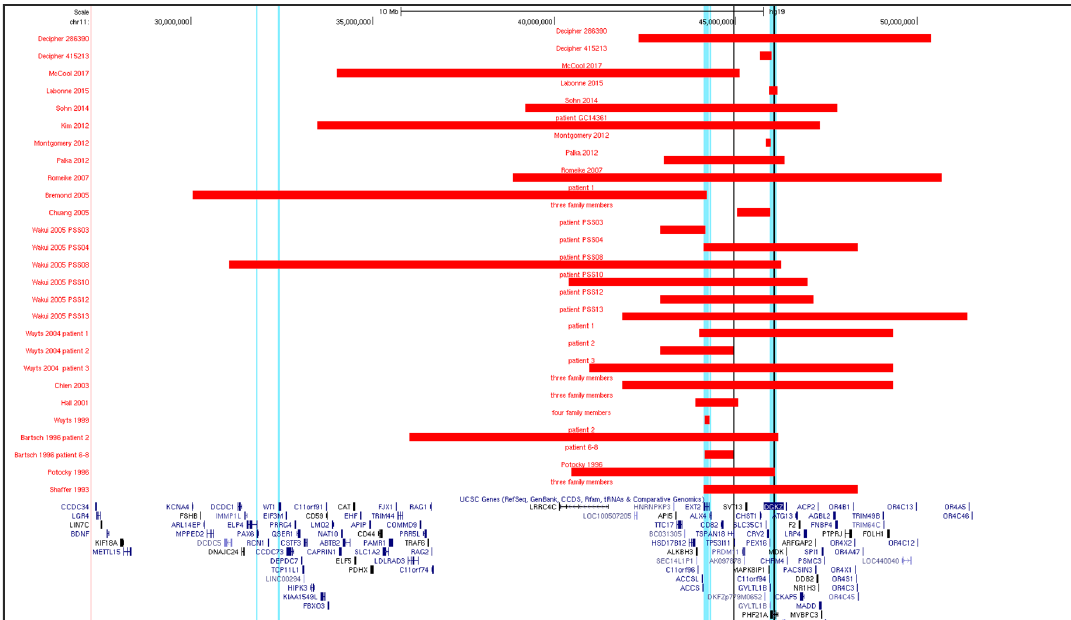
Figure 3. Scheme for the 40 known deletions encompassing the Potocki-Shaffer syndrome (PSS) critical region. In red, the extension of the minimal deleted region. Vertical light blue lines indicate the borders of the critical PSS region, spanning the PHF21A , ALX4 , and EXT2 genes. Black vertical lines indicate the redefined critical region for ID/DD in PSS: a ~1.1 Mb region containing 12 annotated genes between markers D11S554 and D11S1319 [22]. On the left side, the PAX6 and WT1 genes associated with Wilms’ tumor, aniridia, genitourinary anomalies/gonadoblastoma and mental retardation syndrome (WAGR). Note that some of the red bars indicate more than one case in the same family.